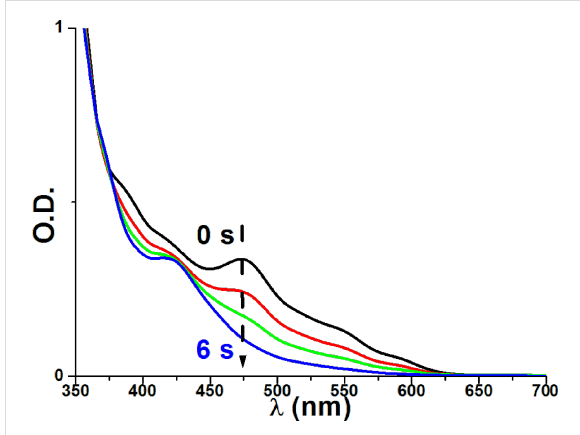
Figure 8: Photolysis of a Ir(piq) 2 (tmd)/Ph 2 I + solution ([Ph 2 I + ] = 0.023 M, in acetonitrile) upon a halogen lamp exposure.